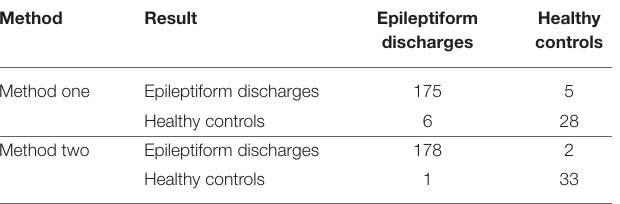
TABLE 3 | Confusion Matrix for the testing data of 180 epileptiform discharges and 34 normal controls: Method One uses Signal Range and H , Method Two is based on the networks constructed from the Signal Range, the energy of the alpha wave component, and the H .